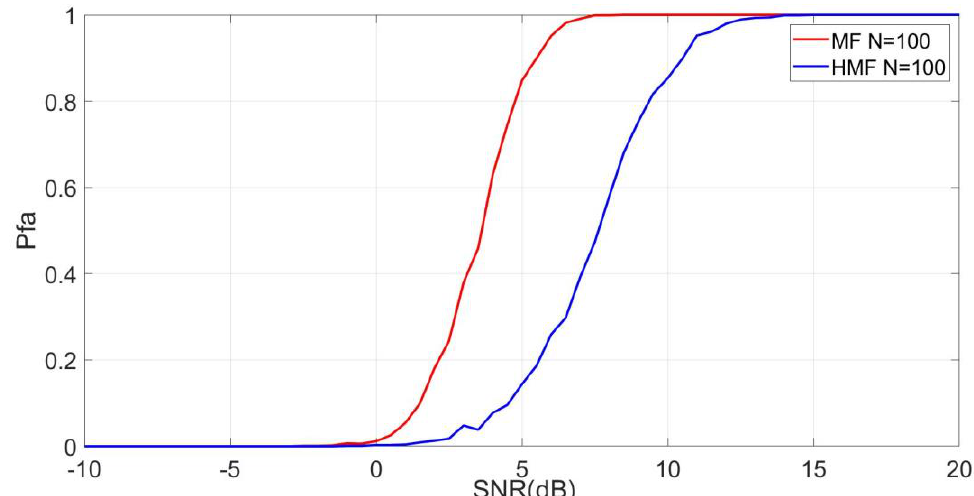
Figure 11. Performance of probability false alarm and signal-to-noise ratio (SNR) for HMF and MF, considering number of samples = 100 in the Rayleigh Channel.